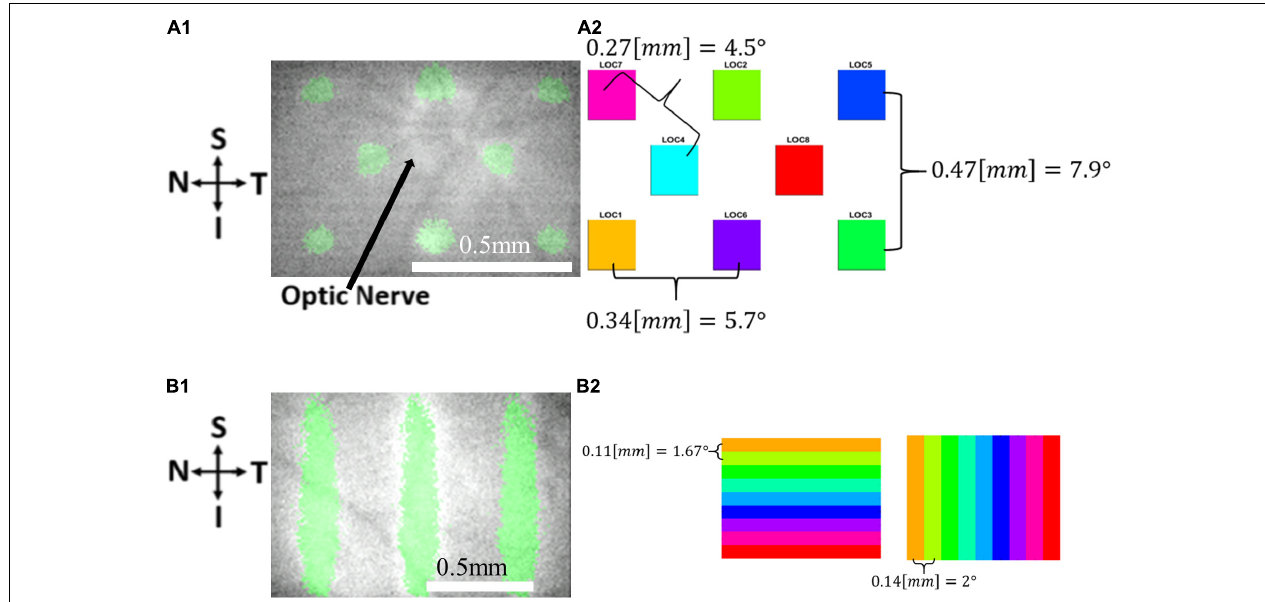
FIGURE 2 | The visual stimuli used in the VSDI experiments. (A) Retinal imaging (A1) and a schematic drawing (A2) showing the 8 location stimuli. (B) Retinal imaging (B1) and a schematic drawing (B2) showing the 9 bar stimuli: Horizontal (left) and vertical (right) 9 bar